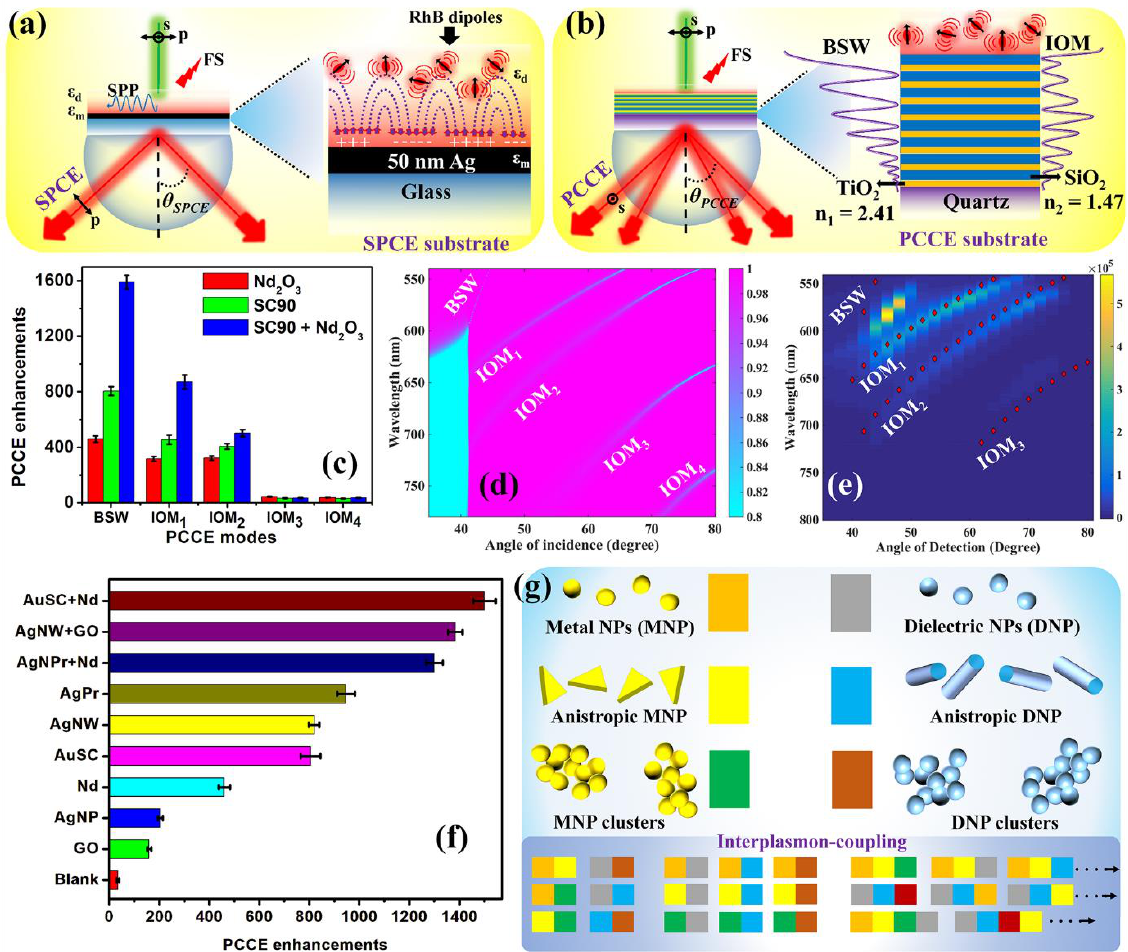
Figure 4. ( a ) Conceptual schematic of coupling of emission with ( a ) propagating surface plasmon polaritons (SPPs) of metal thin film and ( b ) surface-trapped modes of 1DPhC. The magnified images on the right side of ( a , b ) display the coupling at the nanointerface (metal-dielectric and 1DPhC-dielectric interface). ( c ) PCCE enhancements for different modes (BSWs, IOM 1 , IOM 2 , IOM 3 and IOM 4 ) for Nd 2 O 3 , SC90 and SC90 + Nd 2 O 3 samples. ( d ) Numerical dispersion diagram in the angular range from 35° to 80°. The color bar represents the reflectance in arbitrary units. ( e ) Dispersion diagram presenting overlap of numerical (dotted line) and experimental data for 60 nm PVA-doped SC90 + Nd 2 O 3 in the PCCE platform. We have chosen this data for the representation of typical emission patterns and theoretical understanding observed using the PCCE platform. ( f ) Experimental fluores- cence enhancements obtained with different nanomaterials in the PCCE platform. (Acronyms: GO: Graphene oxide; AuSC: gold soret colloids; AgNWs: silver nanowires; AgNPrs: silver nanoprisms; Nd/Nd 2 O 3 : neodymium (III) oxide). ( g ) A snapshot of the futuristic scope of the photoplasmonic nanointerface indicating different opportunities of combining plasmonic and dielectric materials in SPCE, FPoM and PCCE platforms. The color shades are used to make the representation much simpler. Adapted with permission from